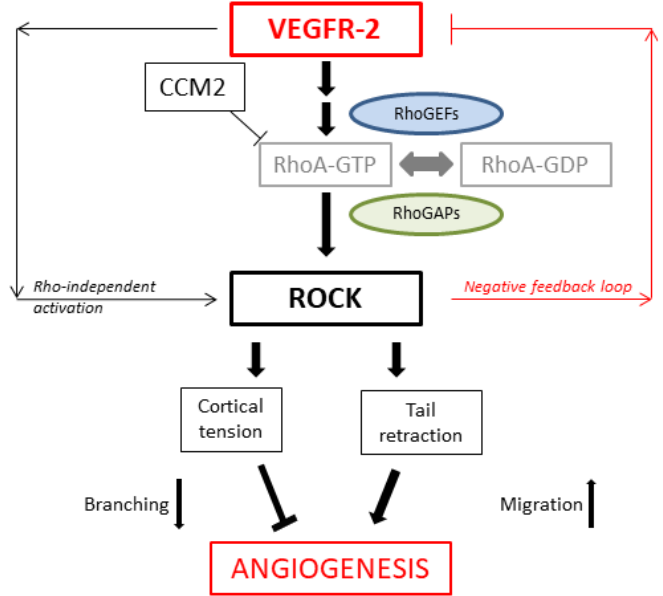
Figure 12. Dual role of ROCK signaling in regulation of angiogenesis; adapted from [38].